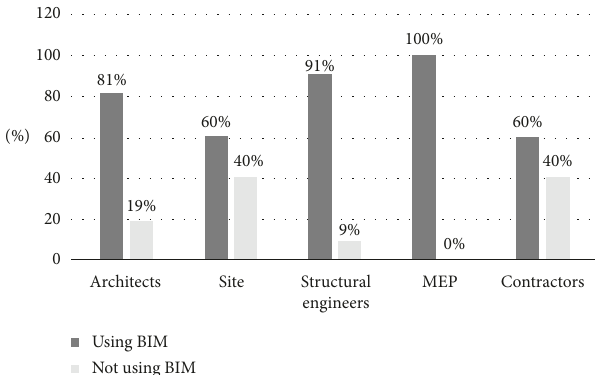
Figure 2: Relationship between the role of the respondent and the company’s use of BIM (total N